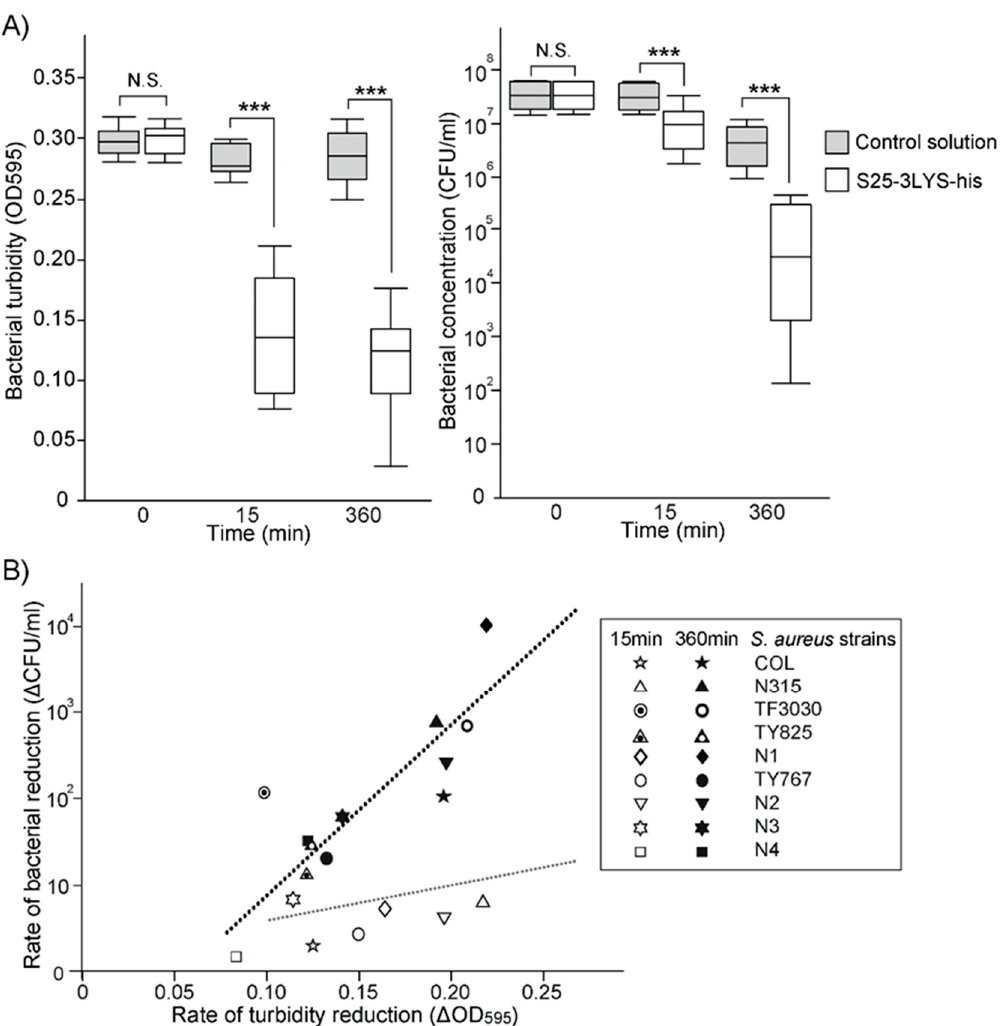
Figure 1. Description of S25-3LYS-his activities against S. aureus . ( A ) Comparison of bacterial turbidity (left) and bacterial reduction (right) between the control and S25-3LYS-his groups. At 15 min of incubation, bacterial turbidities (OD 595 ) of the control and S25-3LYS-his groups were 0.284 ± 0.013 and 0.141 ± 0.005, respectively (mean ± SD). At 360 min of incubation, the bacterial turbidities of the control and S25-3LYS-his groups were 0.286 ± 0.023 and 0.115 ± 0.045, respectively. At 15 min of incubation, the bacterial concentrations (log 10 CFU / mL) of the control and S25-3LYS-his groups were 7.41 ± 0.24 and 6.80 ± 0.39, respectively. At 360 min of incubation, the bacterial concentrations of the control and S25-3LYS-his groups were 7.41 ± 0.24 and 6.80 ± 0.39, respectively. Statistical significance is indicated as “***” ( P < 0.005); no statistical significance is indicated as “N.S.”. ( B ) Correlation analysis between turbidity reduction and bacterial reduction in the S25-3LYS-his-treated groups, measured at 15 and 360 min. The regression lines are separately plotted around the data points at 15 min ( R 2 = 0.22) and 360 min ( R 2 = 0.76), which are shown in gray and black, respectively. The S. aureus strains tested are shown in the right-hand box.